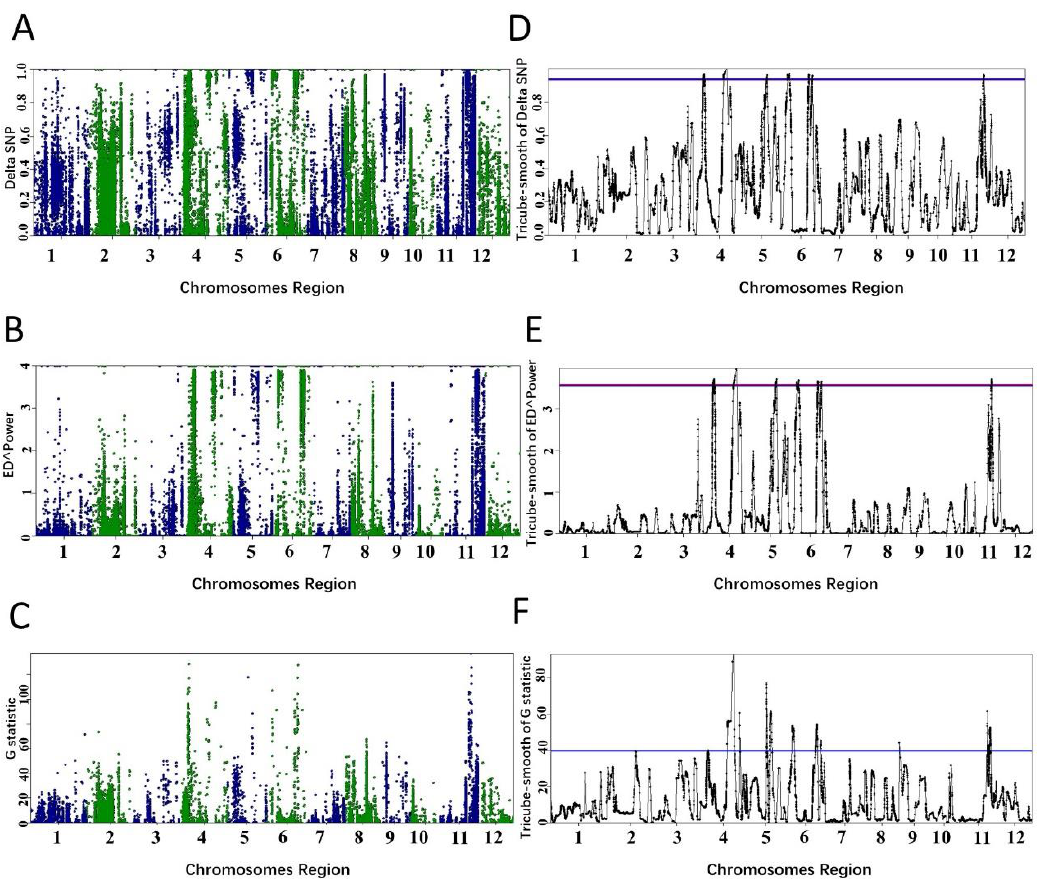
Figure 6. QTL identified by different algorithms in PNGseqR for rice cold tolerance in a RIL population. Plots were drawn by the “plot_BSA()” function with a 1 Mb sliding window. ( A – C ) The scatter plots were drawn by using the ∆ SNP, Euclidean distance, and G-test algorithms. ( D – F ) Tricube-smoothed values on the genome. The red line is the threshold set by the >95% quantile and the blue line is the threshold set by p -values < 0.05.